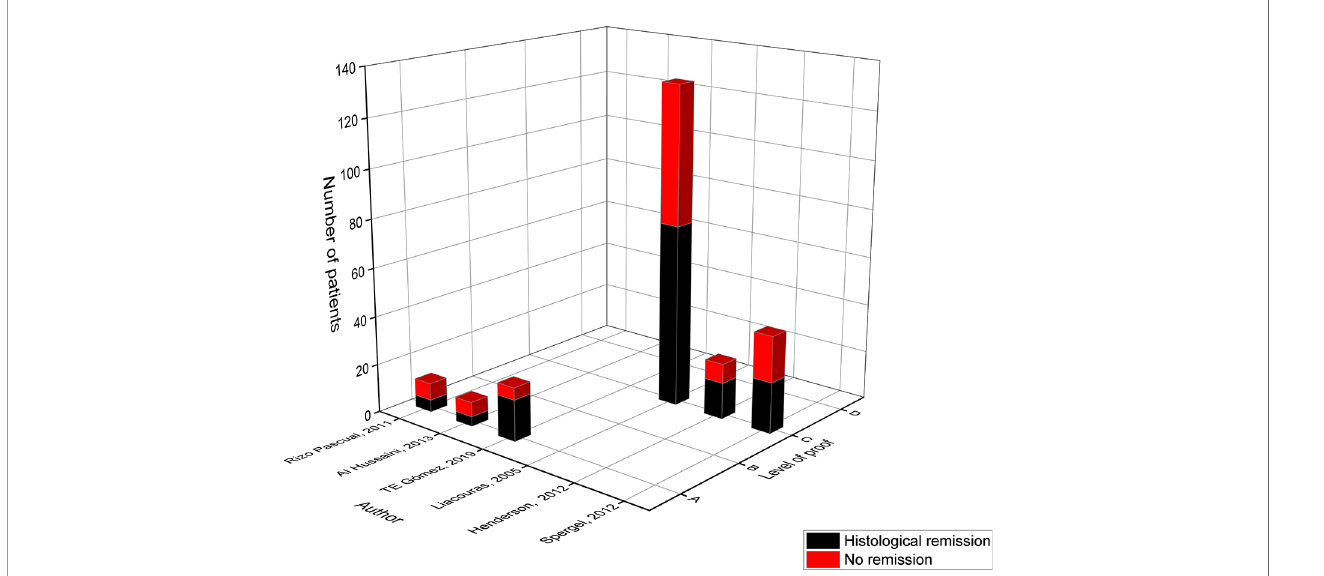
FIGURE 3 | Level of proof of studies on the allergy test-directed elimination